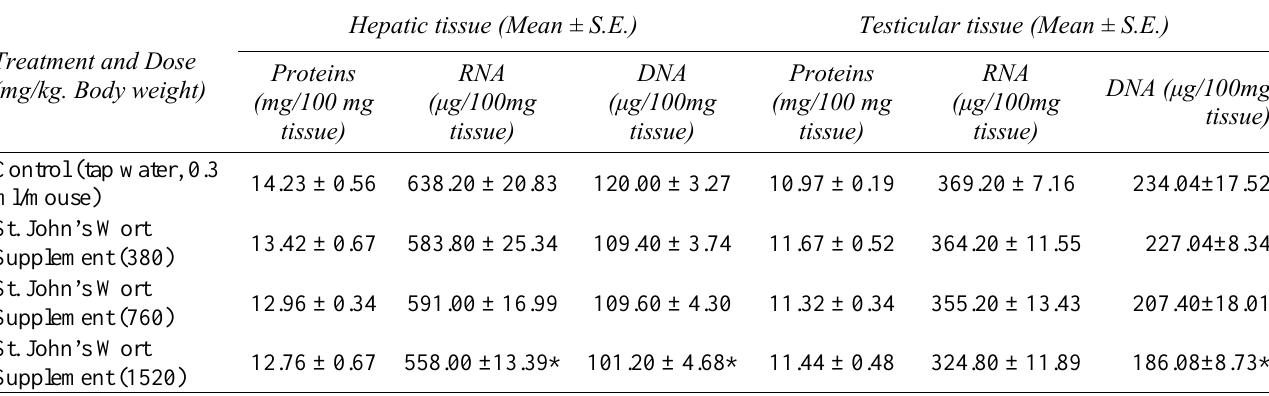
Table 4: Effect of St. John’s Wort Supplement on Protein and Nucleic acid contents in hepatic and testicular tissue of Swiss albino mice after Sub-acute treatment